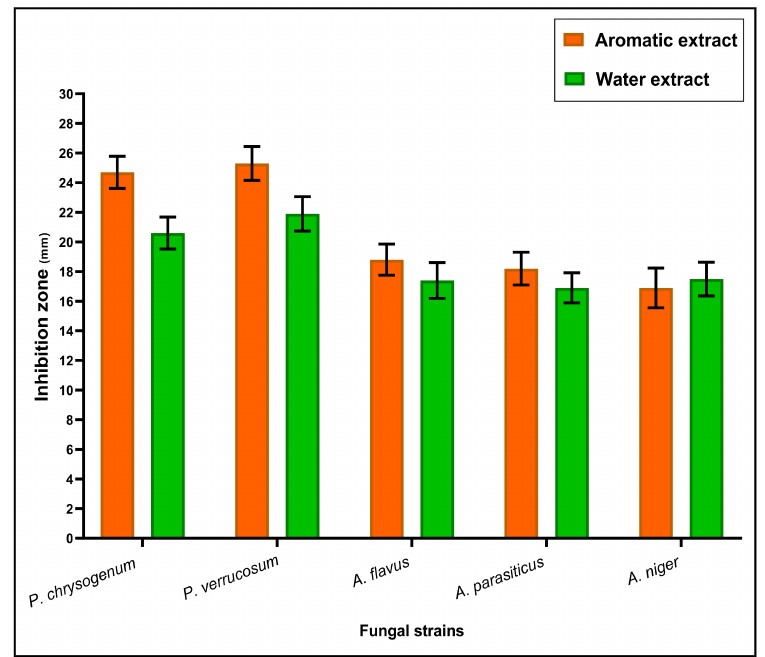
Figure 2. Antifungal and anti-mycotoxigenic effect of a mixture (ginger:thyme:coriander) extract types against pathogenic bacterial strains. Results were expressed as means ± S.D. (n = 3), inhibition zone diameter represented in millimeters; The aromatic extract was applied in the nano-form of chitosan